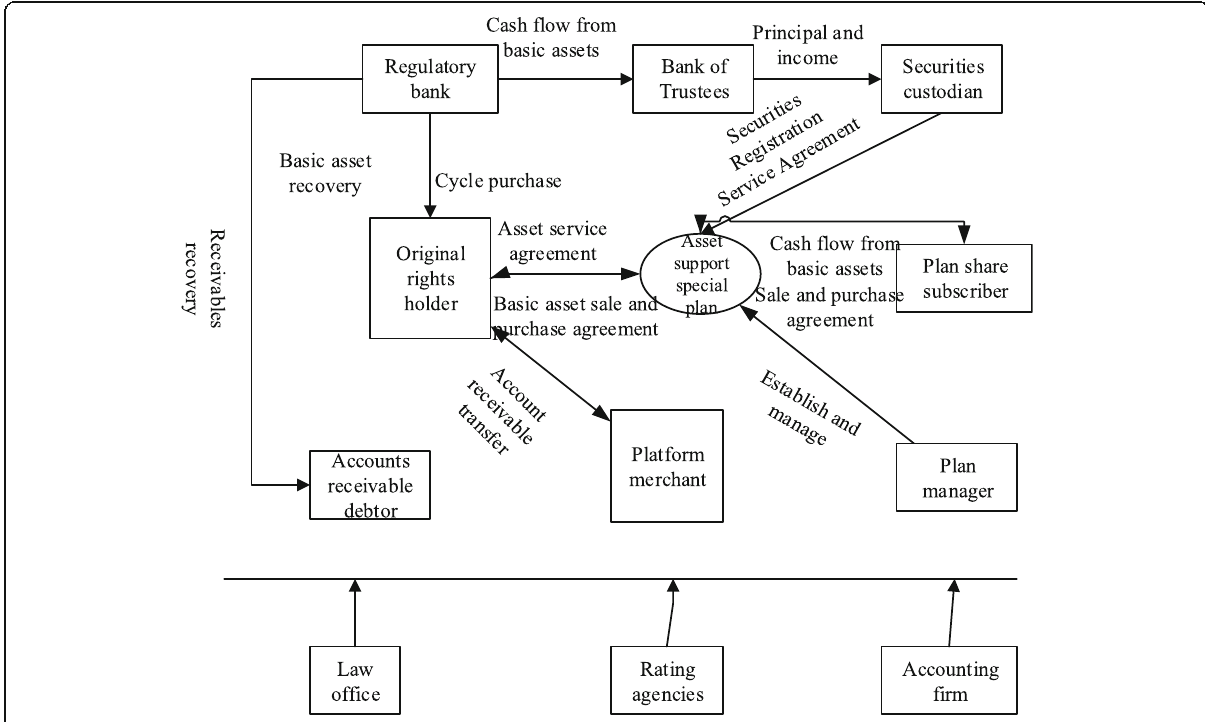
Fig. 5 Traditional trading structure of Internet consumer financial